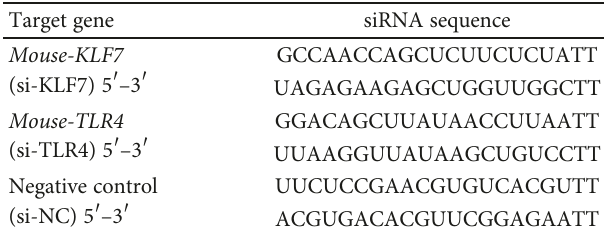
Table 1: Small interfering RNA